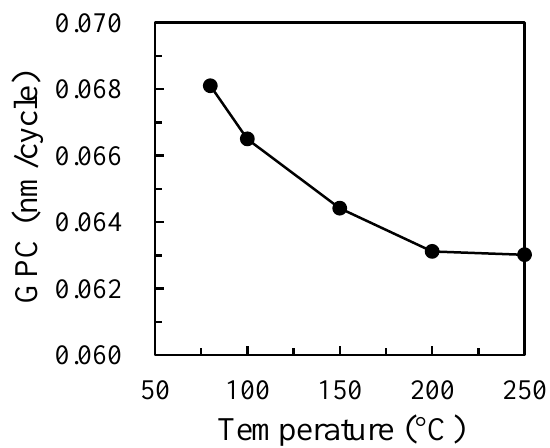
Figure 1. Growth rate of Ga 2 O 3 thin films as a function of deposition temperature.